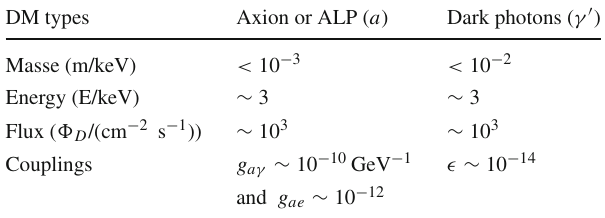
Table 2 Here we list two benchmark points with some known black hole binary sources combined in [71,72]. We assume the dark particle luminosityof the host blackhole is comparable tothe visibleluminosity L D ∼ L E , and those sources are around kpc distance from the